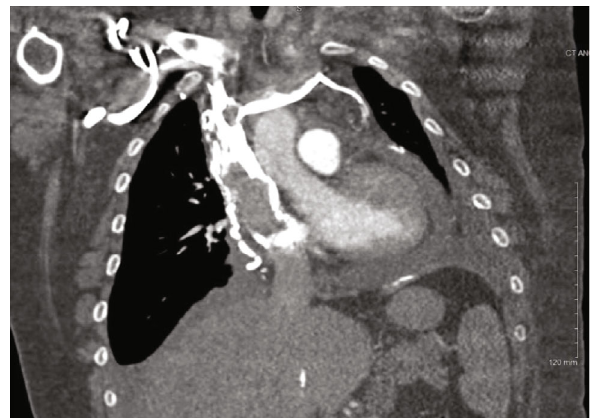
Figure 1: CT of the chest with SVC and subclavian thrombus.